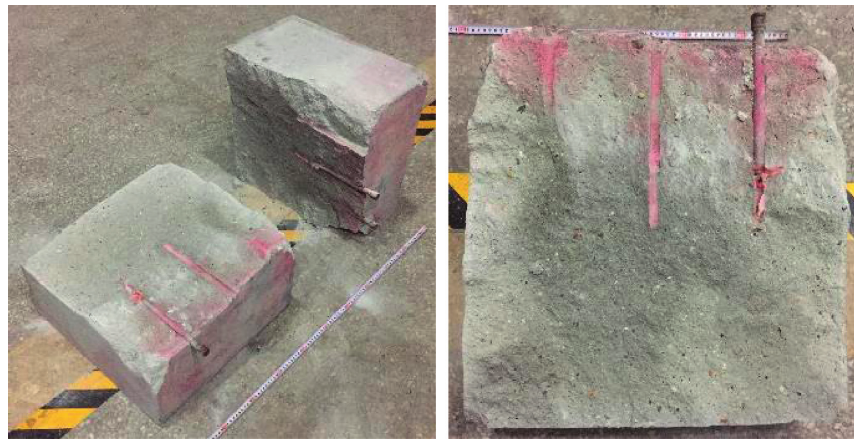
Figure 5: Overall morphology of the directional fracture